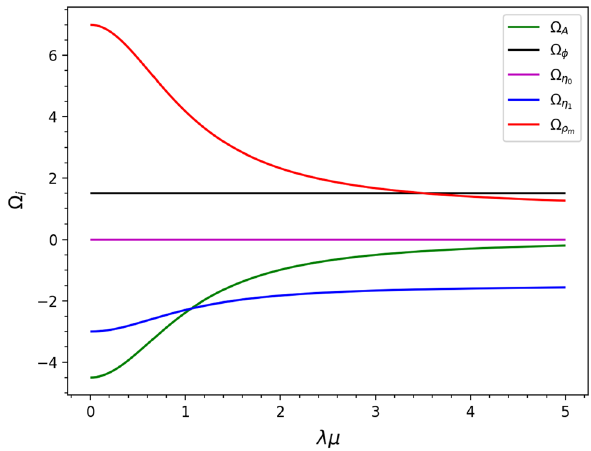
Fig. 7 On the left panel, the graph a shows the stability of the F ( C ) critical point. The stable critical points lie in the blue shaded region while non-shaded region is forbidden for critical points. On the right panel, the graph b illustrates the relation between density parameter